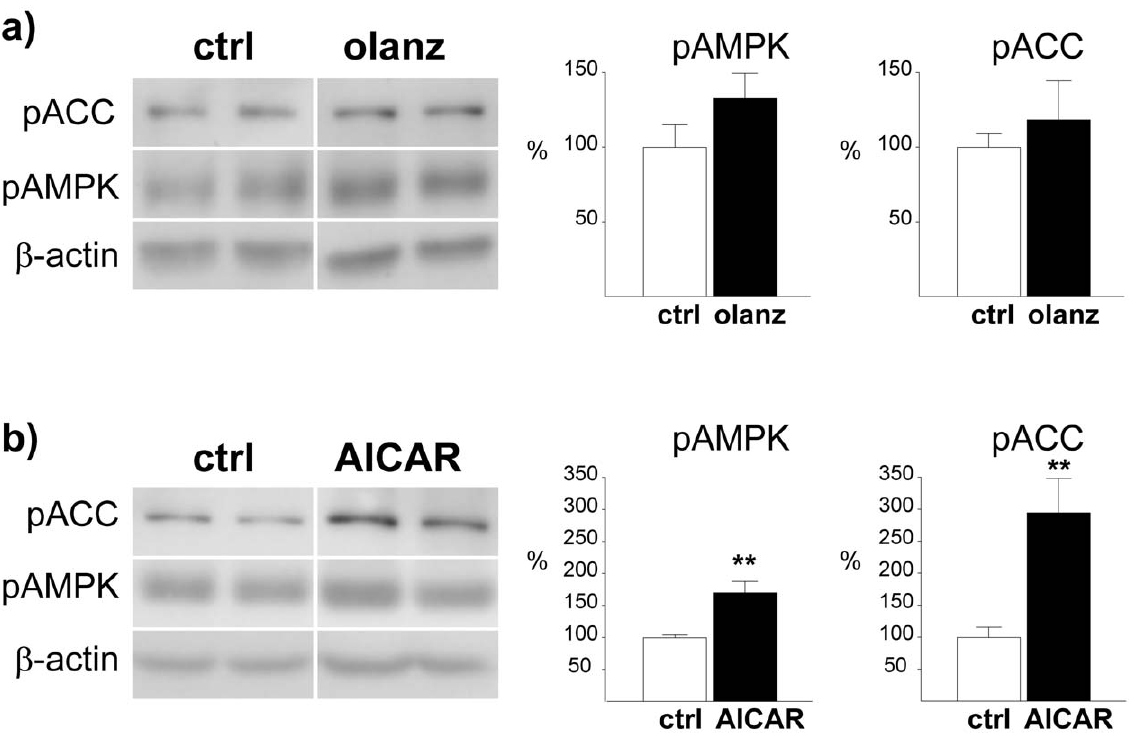
Figure 1. Effect of ICV olanzapine and AICAR administration on phosphorylation of hypothalamic AMPK and ACC. Western blot analysis of hypothalamic pAMPK and pACC from rats sacrificed 30 minutes after ICV injection of a) olanzapine or b) AICAR, relative to control rats (DMSO). Calculations are based on results from 6 rats for each treatment group, run in duplicate. Representative images for the calculated difference were selected. Each lane (pACC, pAMPK and b -actin) always represents results on the same gel from the same rat. * P # 0.05 vs. vehicle. ** P # 0.01 vs.